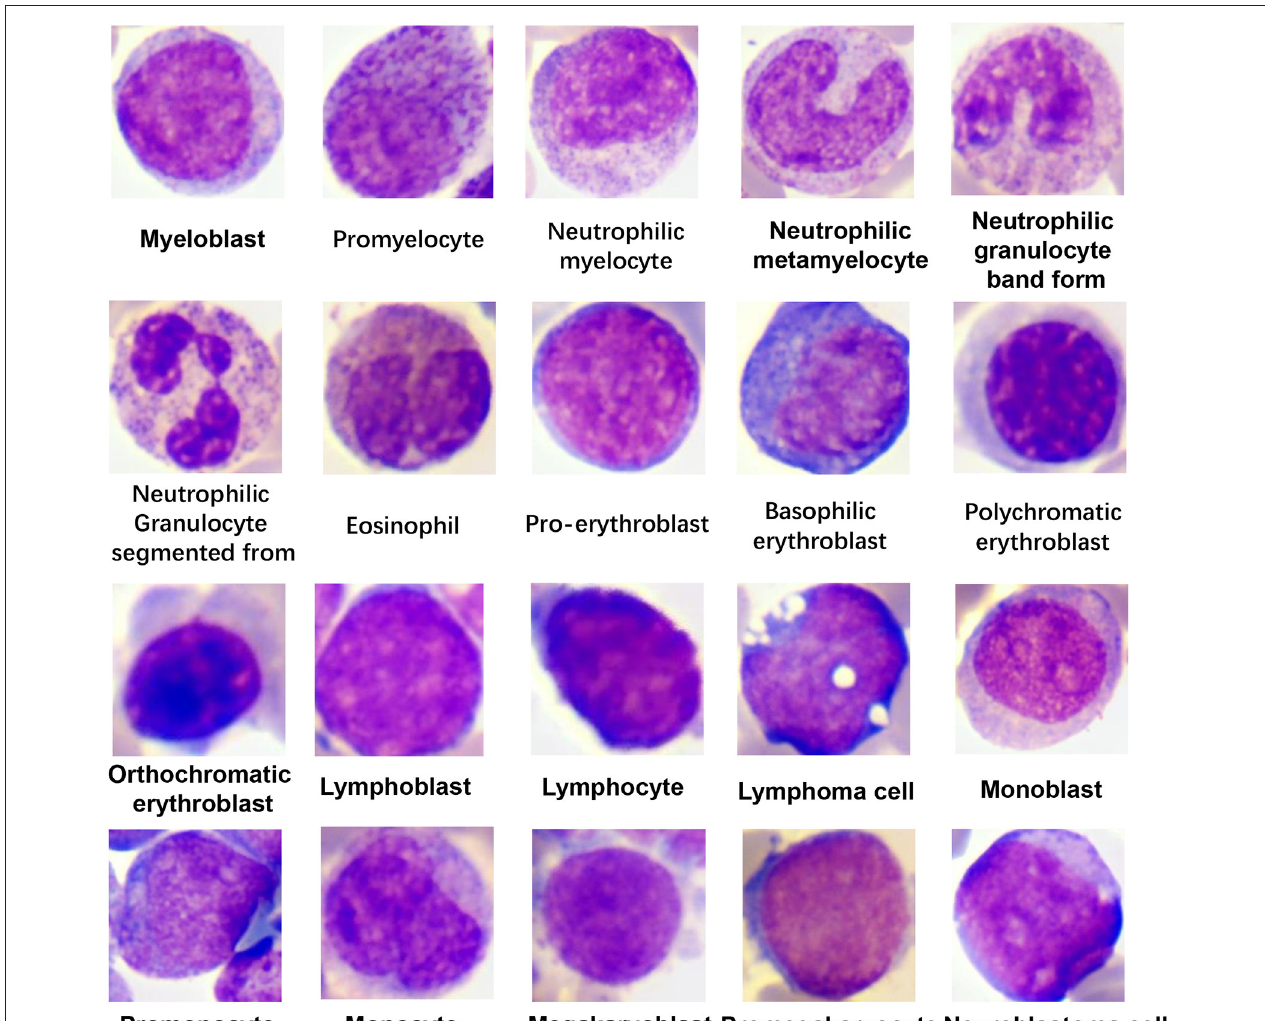
FIGURE 1 | Representative images of the classified cell